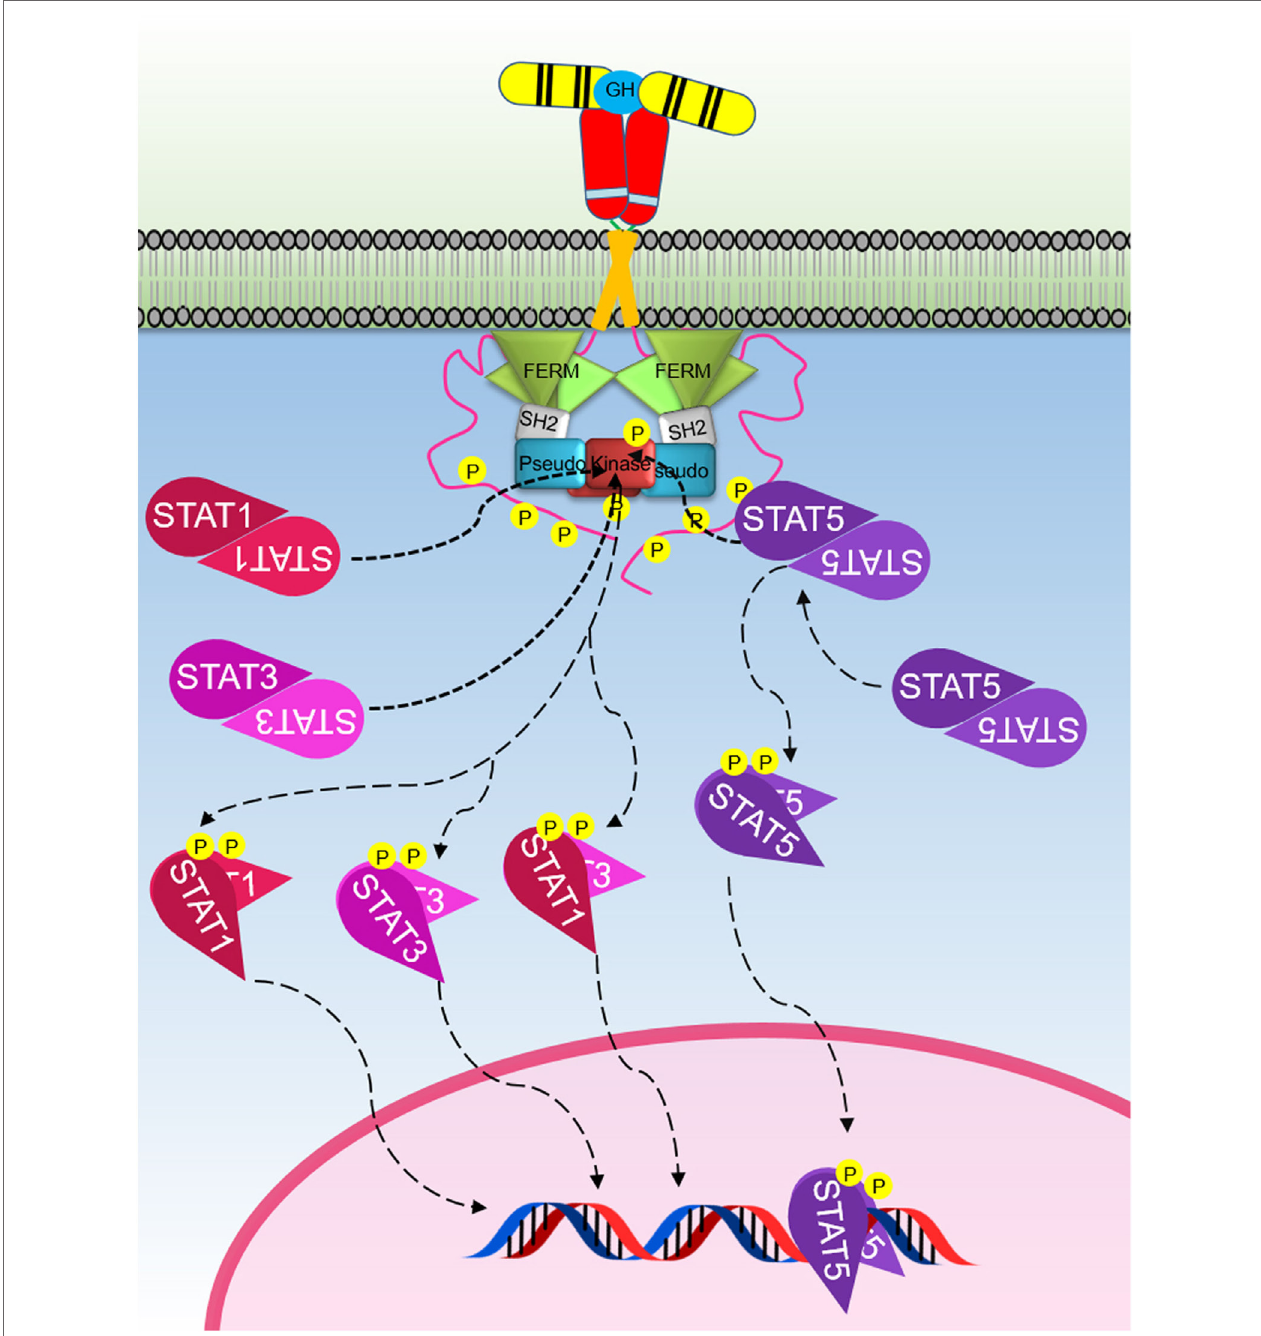
FiGURe 3 | The Janus kinase (JAK)–signal transducer and activator of transcription (STAT) signaling pathway initiated by the activated growth hormone receptor. Activated JAK2 phosphorylates tyrosines on the intracellular domain of the receptor. Inactive-STAT5 dimers bind these phosphorylated tyrosine residues on the receptor, and the STAT5 is subsequently phosphorylated by JAK2 forming different active-STAT5 dimers that are translocated to the nucleus, bind DNA, and act as transcription factors. STAT1 and STAT3 are phosphorylated and activated by JAK2. Active STAT1 and STAT3 form homodimers or heterodimers, are translocated to the nucleus, bind DNA, and act as transcription